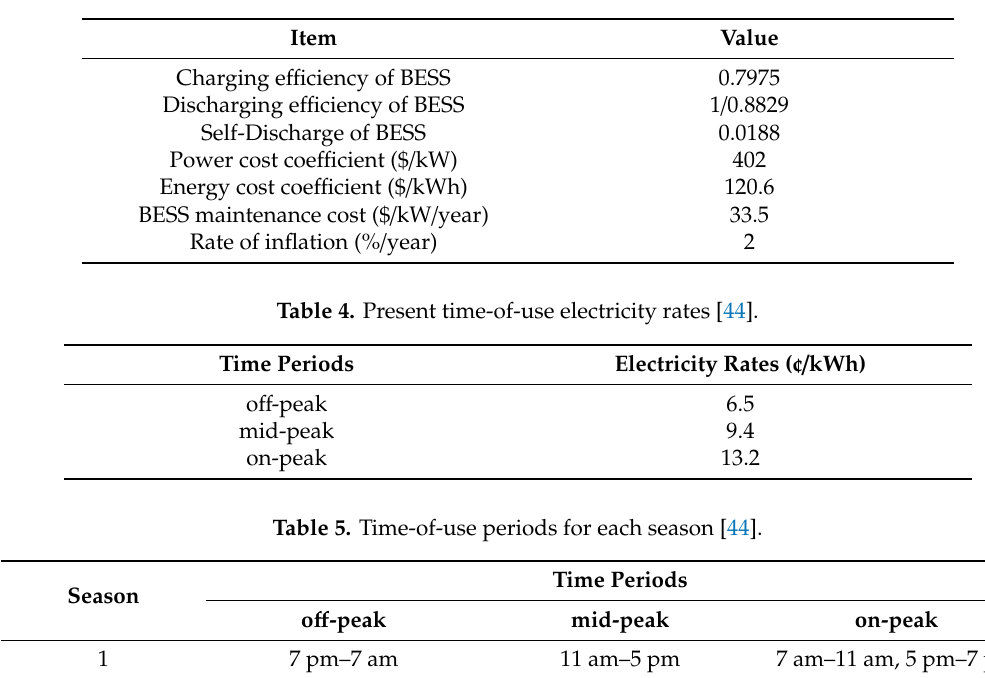
Table 3. Battery energy storage systems (BESS) CAD [41–43].